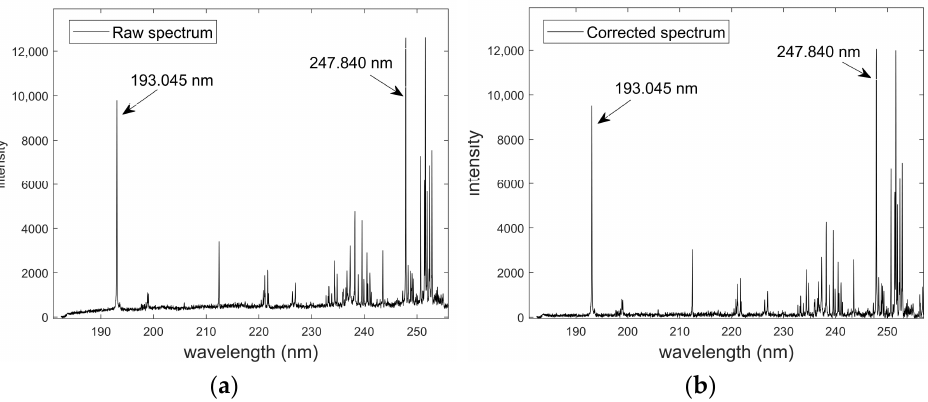
Figure 6. Plot of the effect of baseline correction. ( a ) Original data; ( b ) data following baseline correction. In this paper, the four Ca spectral lines were used to calculate the plasma temperature. The parameters of the spectral lines are shown in Table 2. Table 2. Ca spectral line parameters.